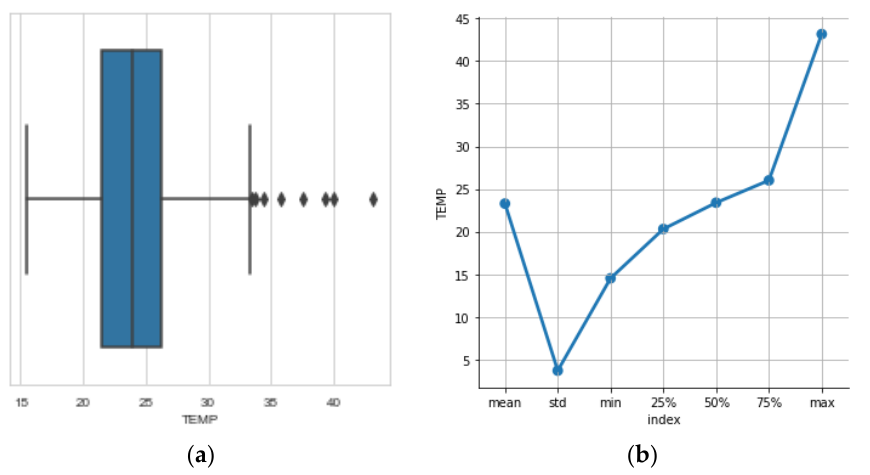
Figure 10. ( a ) boxplots pinpoint outliers in the recordings of temperature ( ◦ C) that are deemed dangerous for the health of the beehive if they are prolonged. This is not the case here. ( b ) mean, std, min and max values are valuable to look out for normal values for temperature fluctuations and